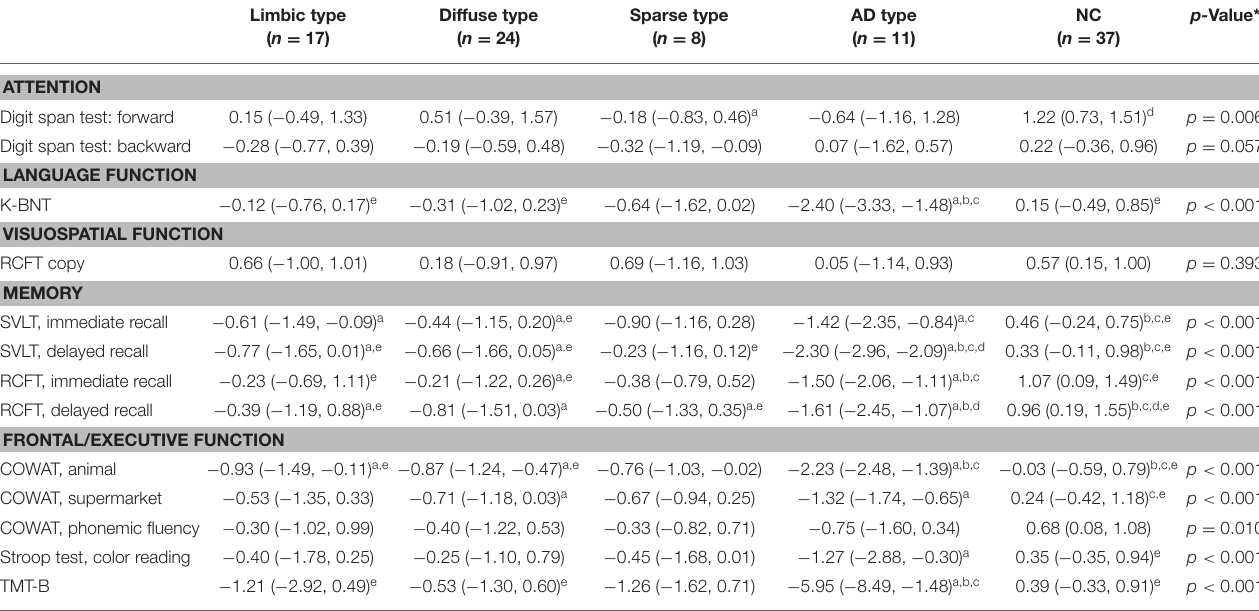
TABLE 3 | Neuropsychological test results.